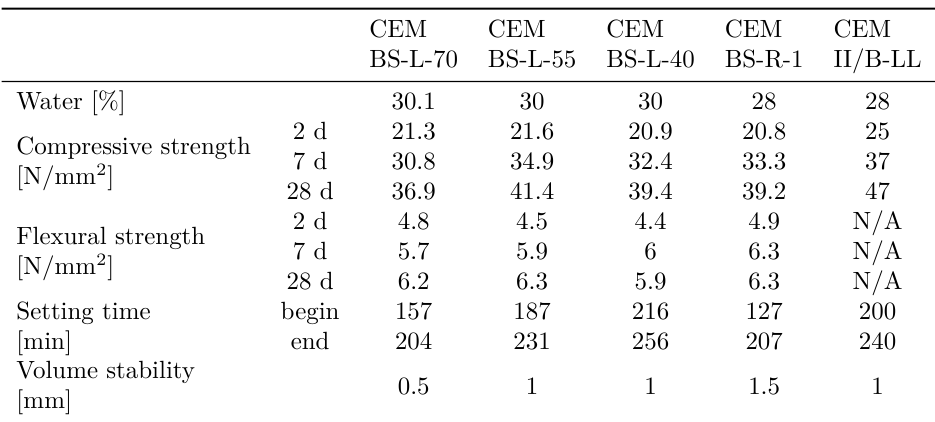
Table 1. Results of cement paste tests compared to CEM II B/LL.